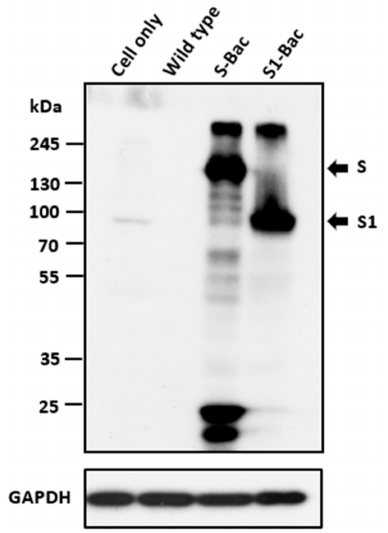
Figure 2. The detection of porcine epidemic diarrhea virus (PEDV) full-length S and S1 proteins in the cell lysate of S-Bac and S1-Bac infected Sf21 cells at 3 days post-infection with an M.O.I. of 5. Western blotting analysis of PEDV S and S1 proteins expressing by baculoviruses was performed and probed with anti-His tag antibodies. The corresponding molecular weights of S and S1 proteins were approximately 170–200 kDa and 90–100 kDa, respectively. Cell only: the non-infected Sf21 cell; Wild-type: Sf21 cells infected with wild type AcMNPV; S-Bac: Sf21 cells infected with S-Bac; S1-Bac: Sf21 cells infected with S1-Bac; GAPDH: control cellular protein for equal volume